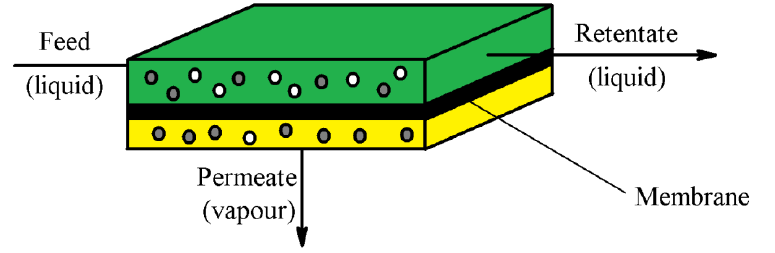
Figure 12. General scheme of a pervaporation.